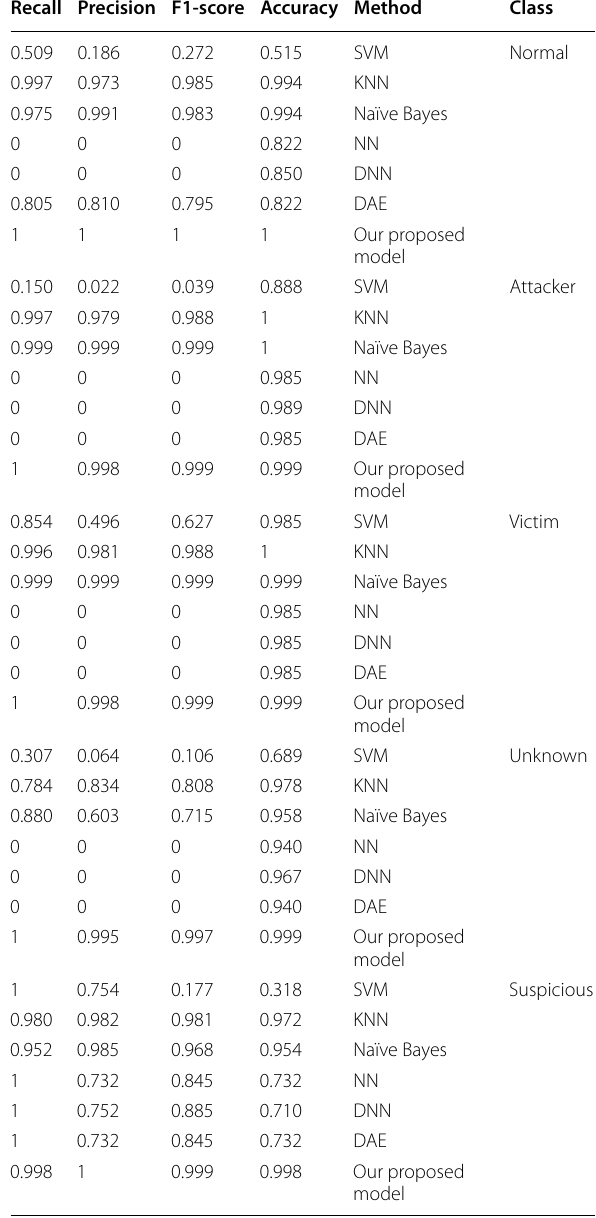
Table 3 Performance comparison of the proposed model with methods presented in [19] including SVM, KNN, Naïve Bayes, NN, DNN and DAE Recall Precision F1‑score Accuracy Method